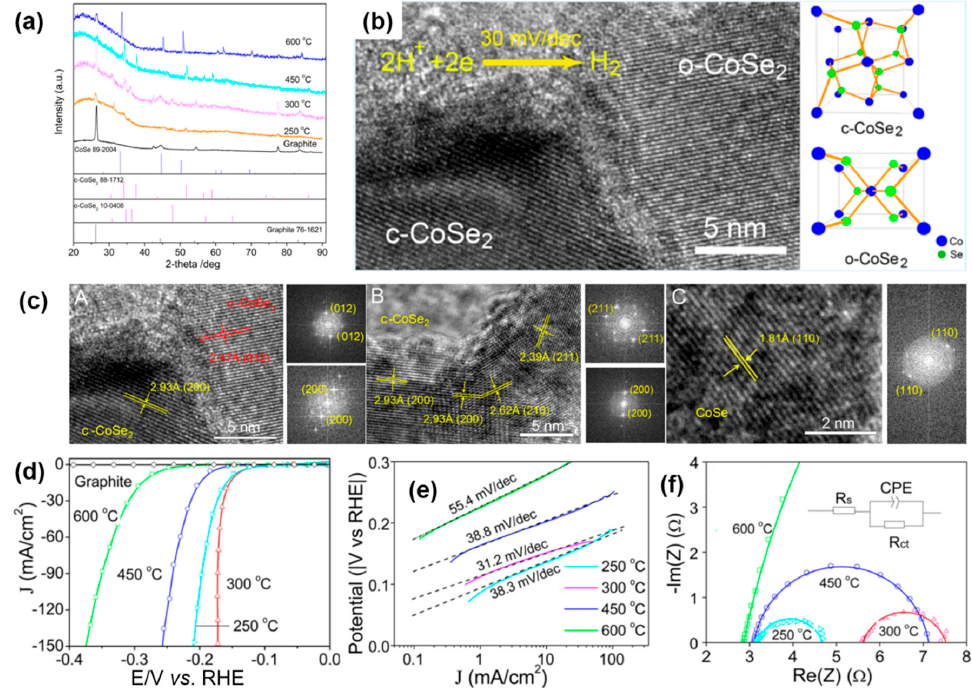
Figure 19. ( a ) XRD patterns of the as-prepared CoSe x /GD samples calcined at different temperatures; ( b ) the crystal structures of cubic CoSe 2 (c–CoSe 2 ) and orthorhombic CoSe 2 (o–CoSe 2 ); ( c ) HRTEM micrographs and electron-diffraction patterns of c–CoSe 2 annealed at 300 °C (A), c–CoSe 2 annealed at 450 °C (B) and CoSe annealed at 600 °C (C), respectively; ( d ) iR -corrected hydrogen evolution reaction (HER) polarization curves (cathodic sweep) of CoSe x (250 °C), c–CoSe 2 (300 °C), c–CoSe 2 (450 °C) and